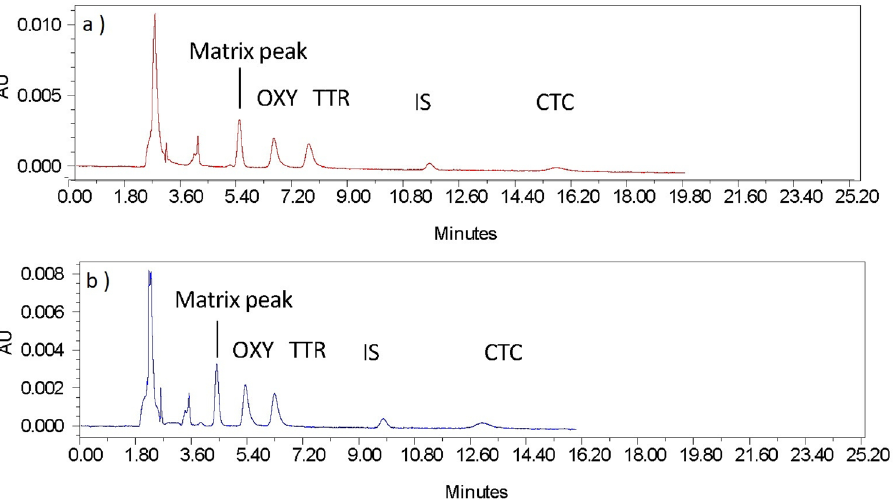
Figure 3. Effect of KH 2 PO 4 concentration on spiked cow milk. ( a ) 25 mM KH 2 PO 4 : ACN: MeOH (70:20:10). ( b ) 10 mM KH